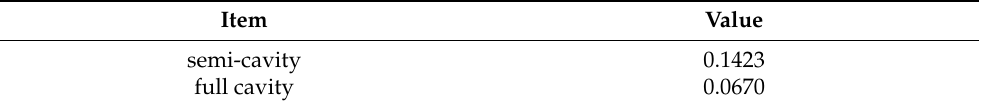
Table 5. View factor (from reactor to